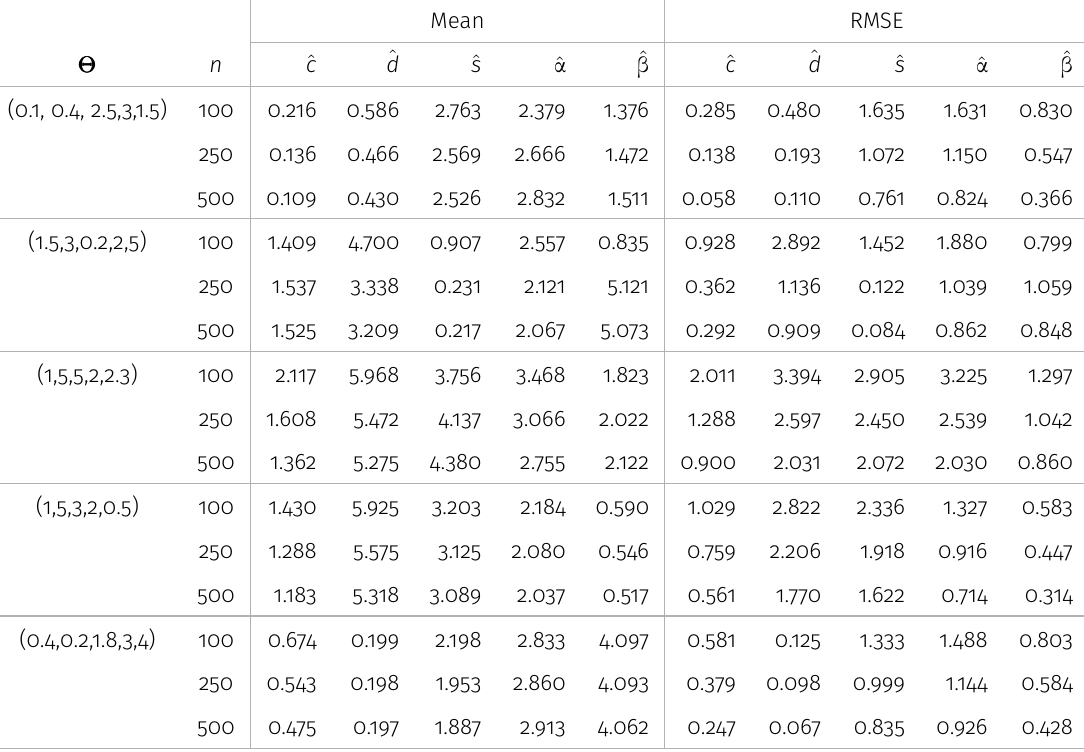
Table III. Mean estimates and RMSEs of the WBXII distribution. Mean